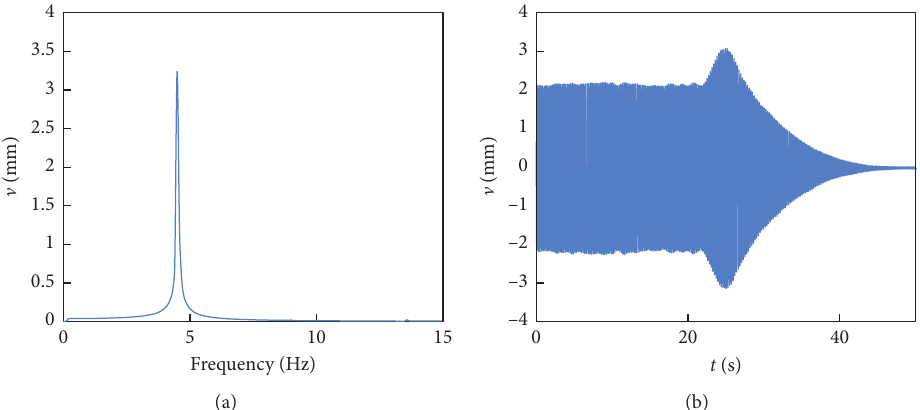
Figure 12: Galloping data obtained from the laser sensor at 1/2 cable length at U curves. (b) Time